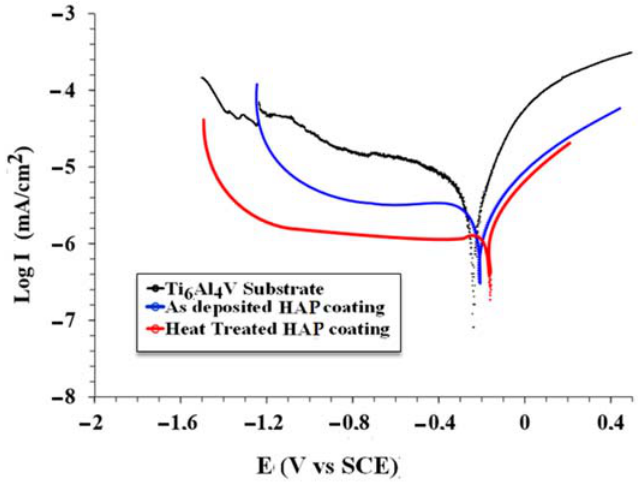
Figure 11. Tafel polarization curves.